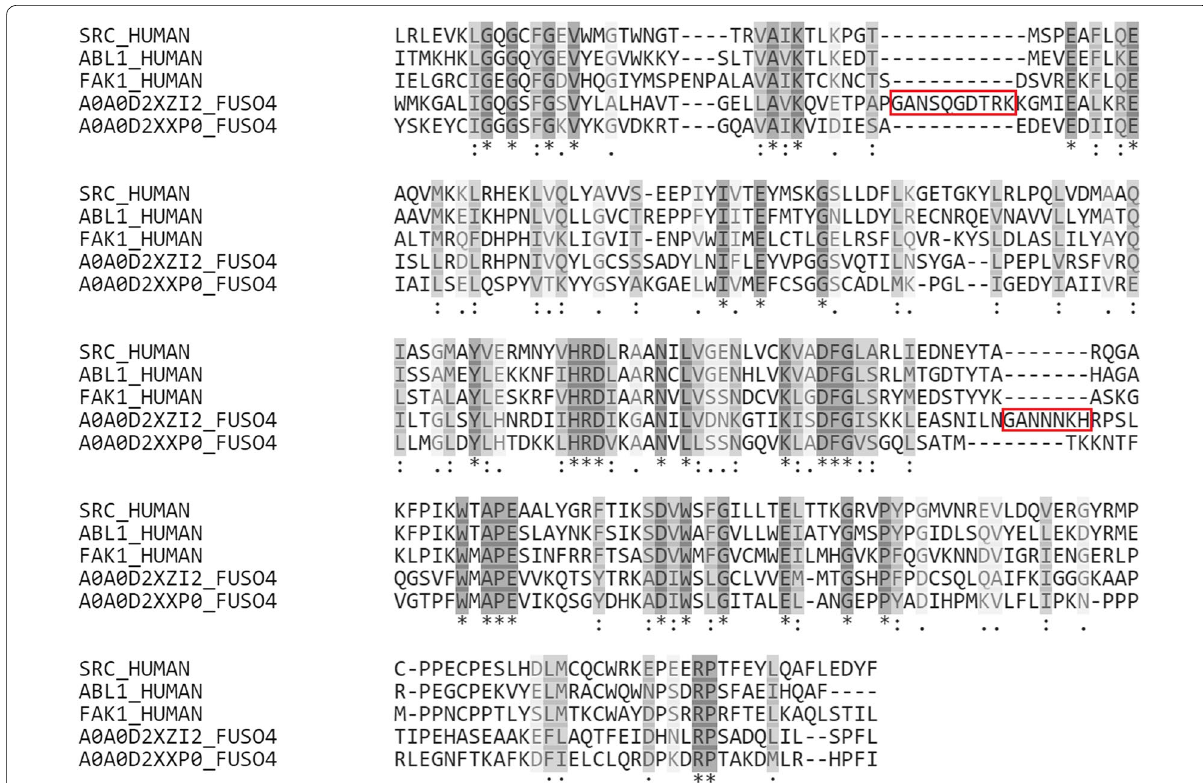
Fig. 1 Multiple sequence alignment results of protein kinase domain of SRC, ABL1, FAK1, and FOL’s proteins